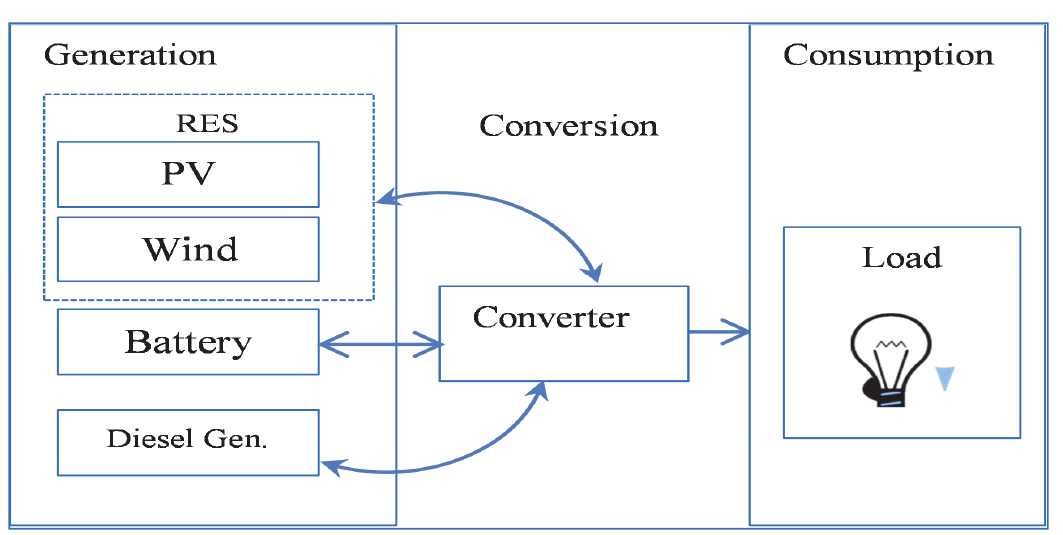
Fig. 1. Proposed HRES model for a